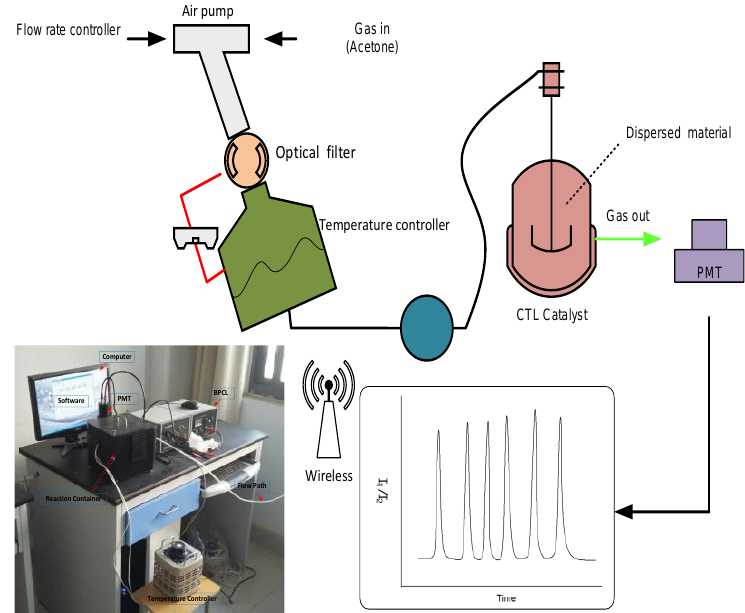
Figure 1. Diagram of the online wireless Cataluminescence sensor system.